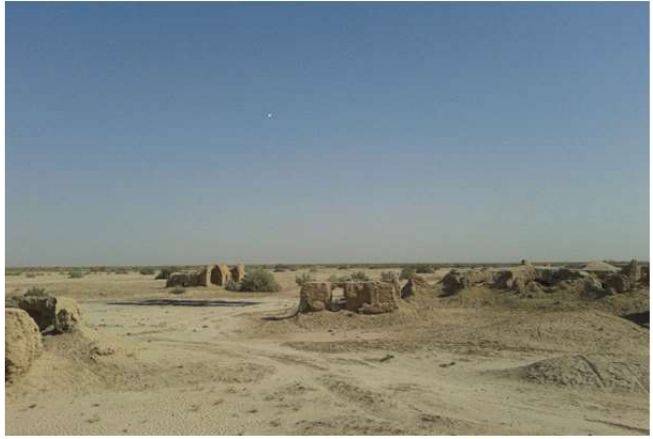
Figure 4. An abandoned village as a consequence of the long-term drought and water scarcity near the city of Qom in Qom Province, north central Iran (Photo: Emadodin).